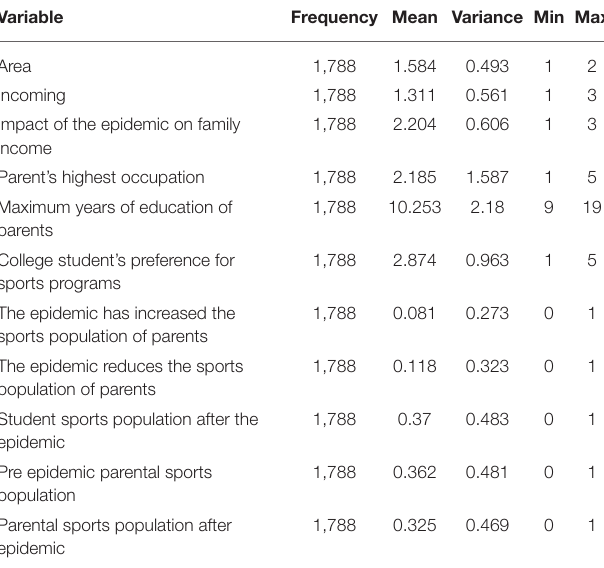
TABLE 4 | Logit regression model of parental sports population changes during new coronary